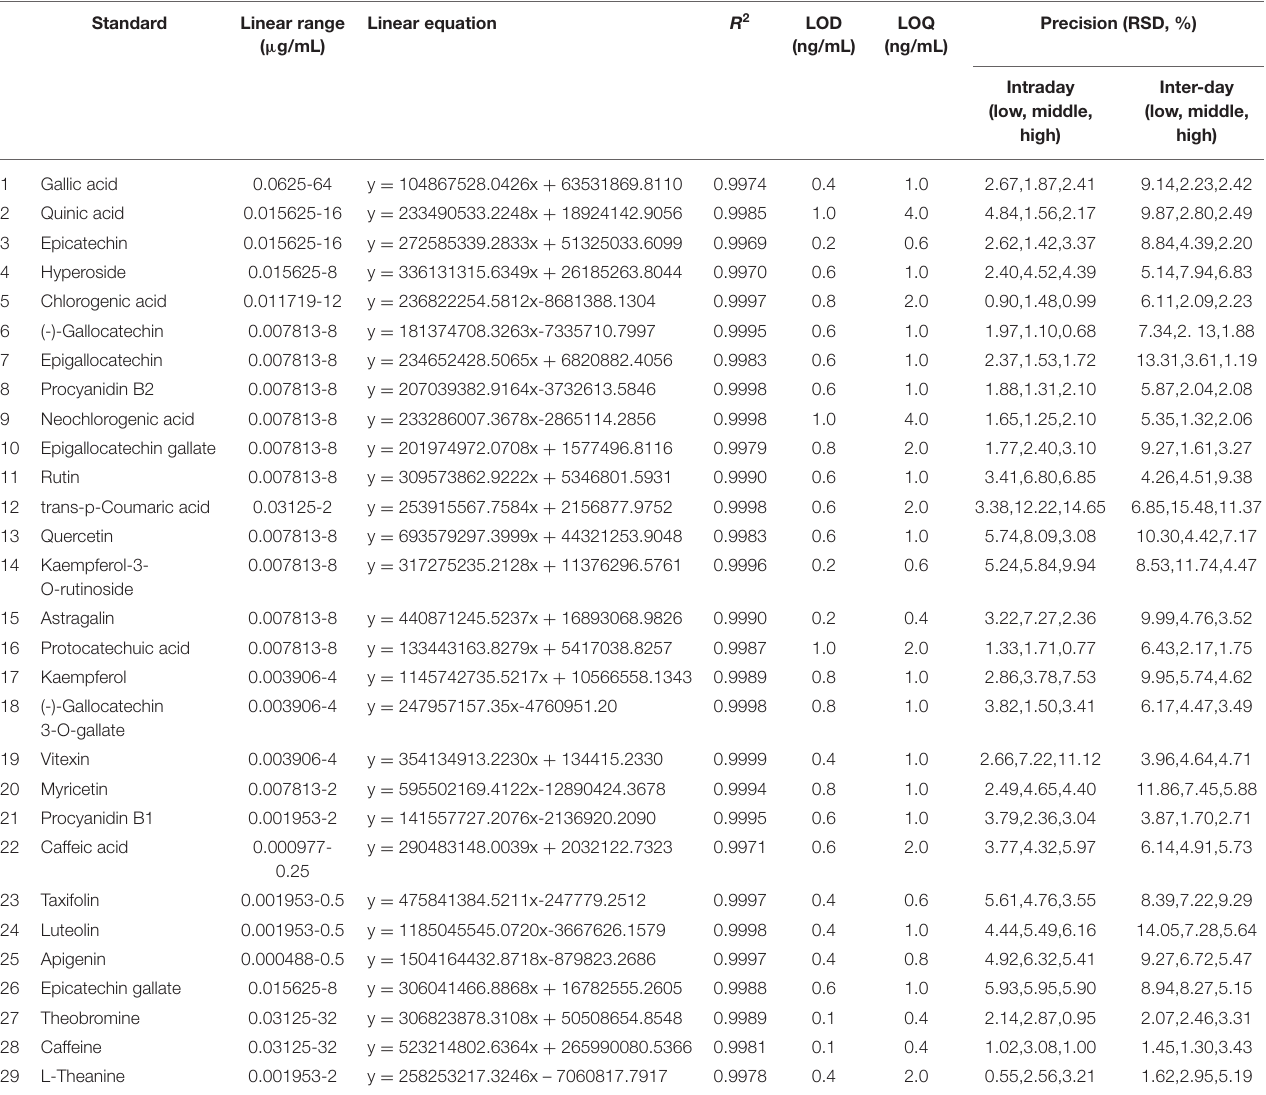
TABLE 1 | Validation results of the quantitative method.